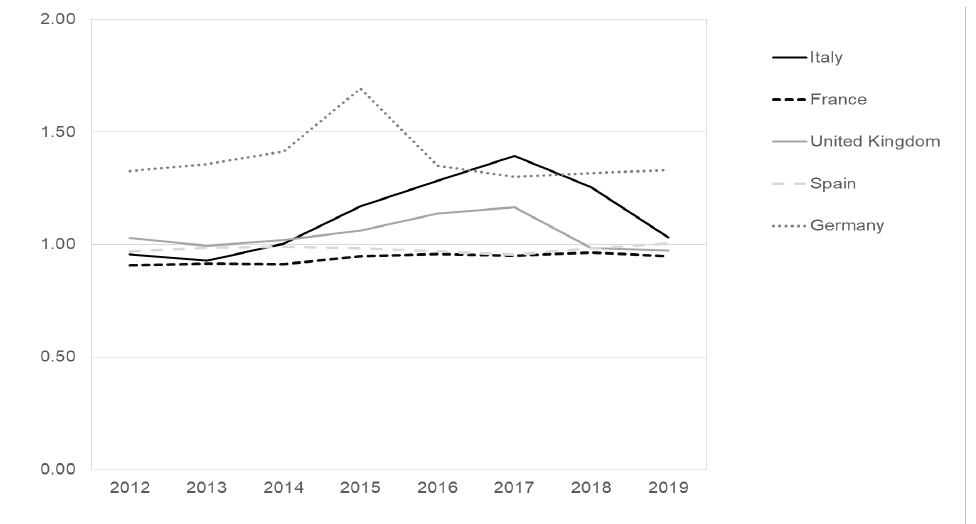
Figure 1 : Inflows of immigrants by gender. Male-to-female ratio in the major receiving countries of immigrants in the